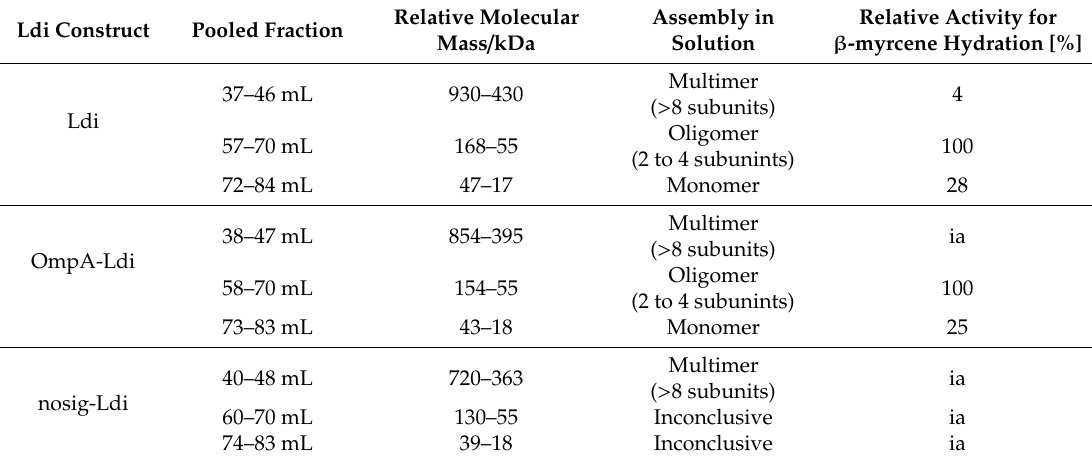
Table 1. The oligomeric assembly of Ldi subunits in solution strongly a ff ects enzyme activity. Ldi gel filtration fractions corresponding to the di ff erent oligomers in solution were pooled and applied in β -myrcene conversions for 19 h under anaerobic conditions. For each Ldi construct, the activities of di ff erent assemblies were set relative to the oligomeric form with the highest β -myrcene conversion. Pooled enzyme fractions without any hydration activity are denoted as ‘ia’